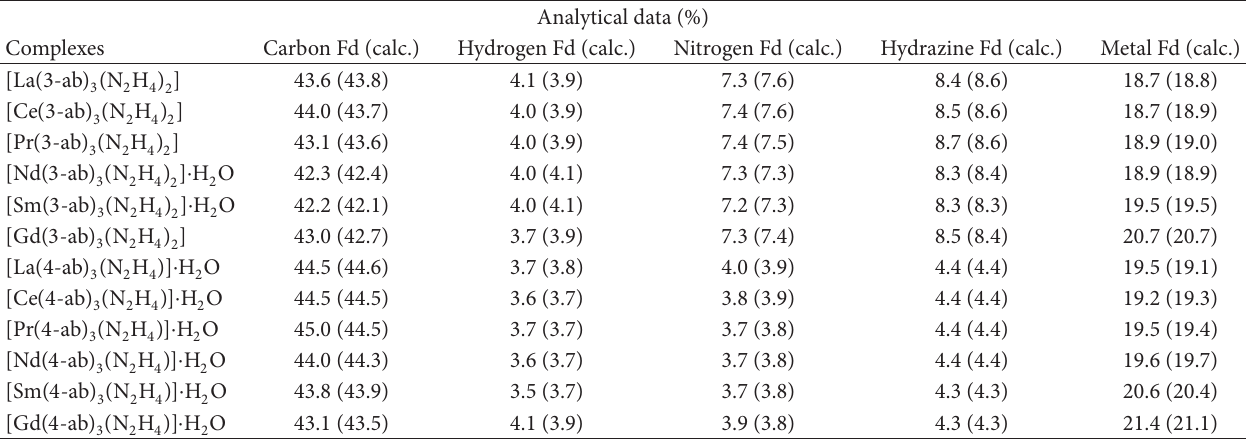
T 1: Analytical data of 3-abH and 4-abH complexes. Analytical data